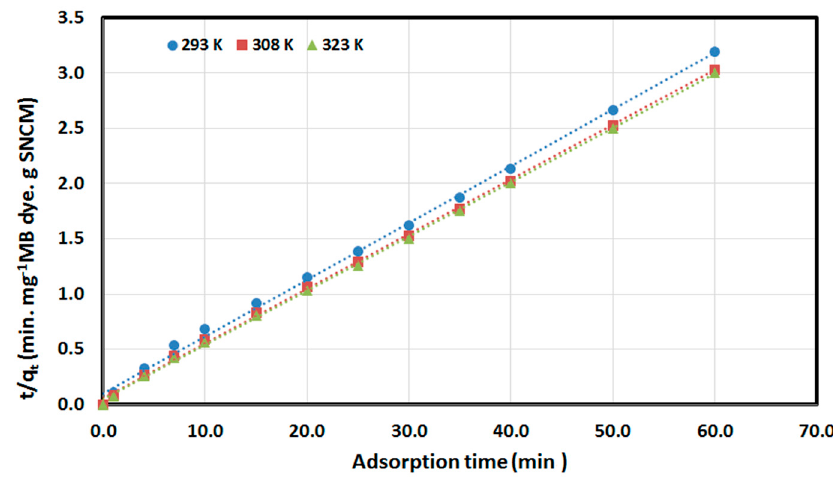
Figure 10. The application of the pseudo-second-order kinetic model for the MB dye removed from an aqueous solution by SNCM.